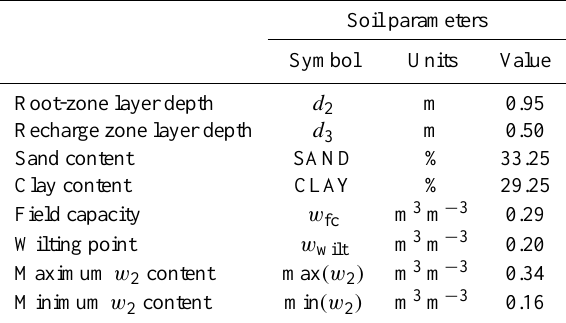
Table 1. Soil parameters used for ISBA-A-gs at the SMOSREX location. The last two lines represent the threshold values for w 2 used to define the simulated Soil Wetness